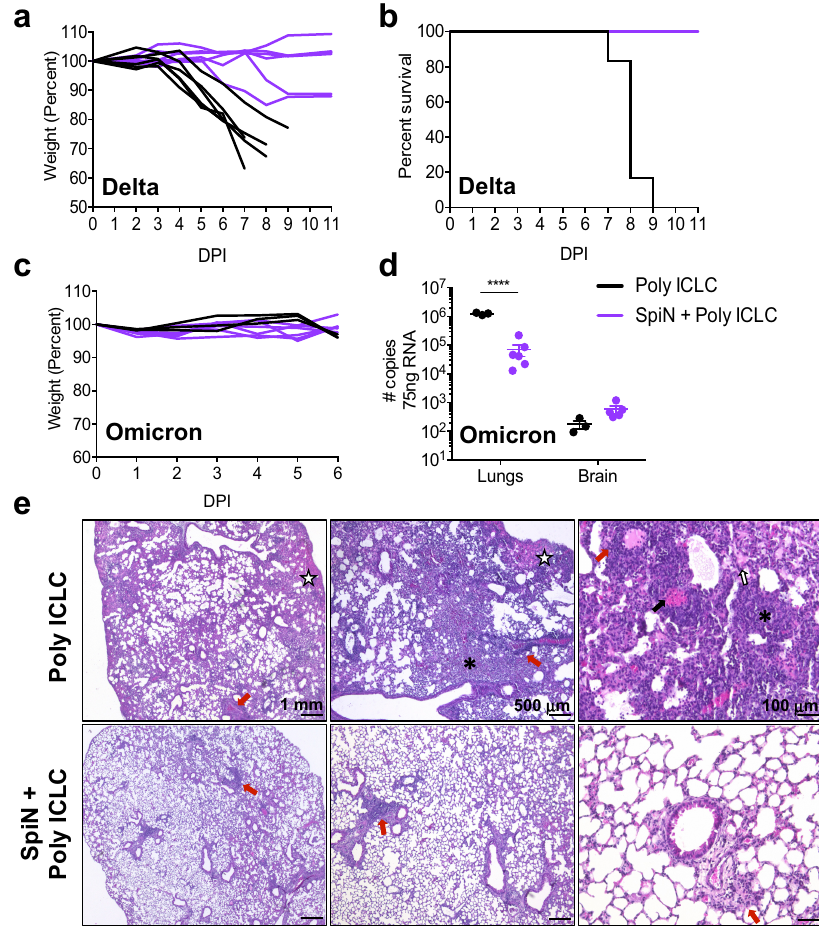
Fig.8|SpiN-inducedprotectiveimmunitytotheDeltaandOmicronvariantsof SARS-CoV-2. K18-hACE2 mice were vaccinated with SpiN associated to Poly ICLC and challenged 30 days after the second dose with 5×10 4 PFU of Delta ( a , b ) or 2.5×10 4 PFU of Omicron ( c , d ) variants. Body weight ( a , c ) and survival ( b ) were measuredfor 11 days. d Viral load wasmeasured by RT-PCRat6 dpi with Omicron, data are presented as mean+/- SEM. a – e 6 mice/group. e Photomicrographs of lung tissue from mice infected with SARS-CoV-2 Omicron strain. Furthermore, in control mice that received Poly ICLC only, the lungs showed a diffuse interstitial pneumonia characterized by a mixed in fl ammatory in fi ltration (mononuclear and